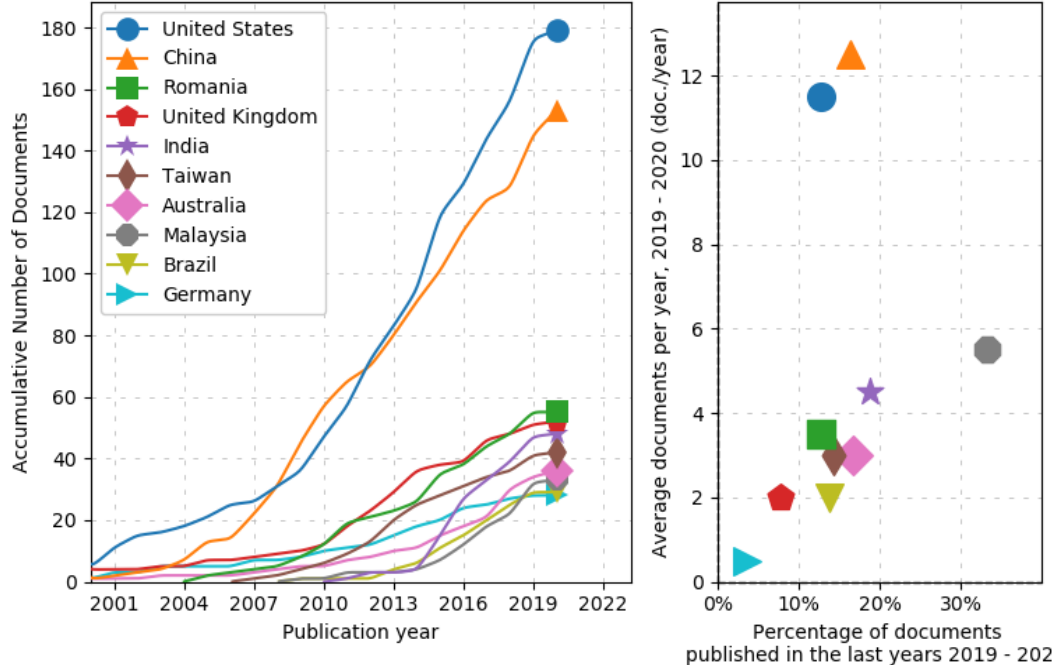
Figure 3. Top ten highest-publishing countries and their